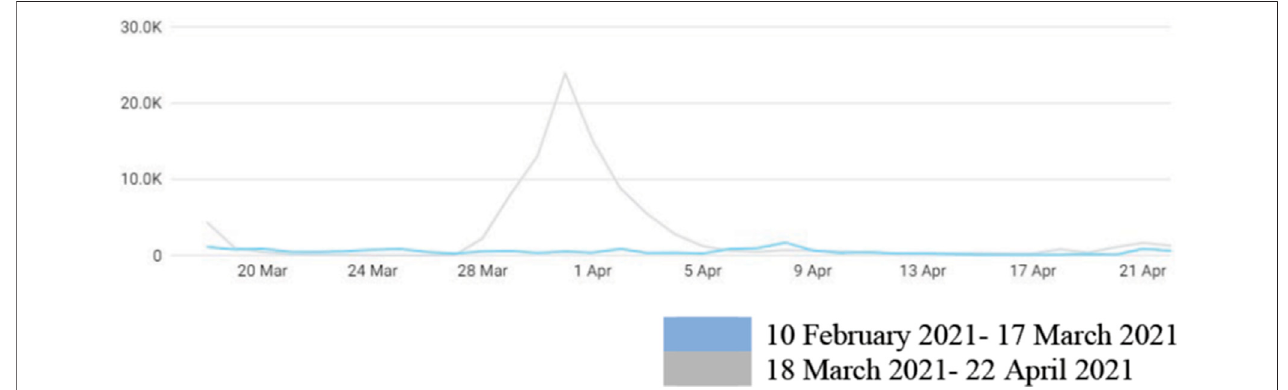
FIGURE 6 | Comparison of Facebook reach during the studied institute sustainability month and the month